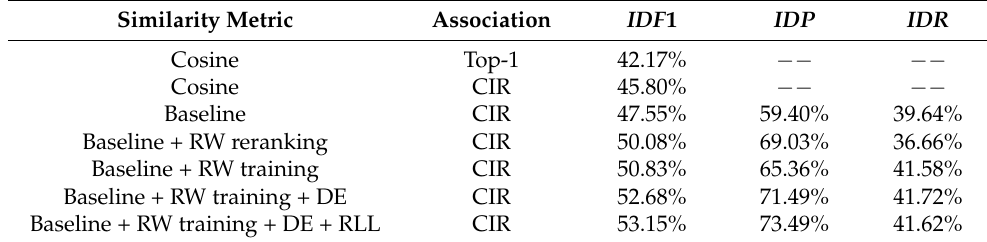
Table 4. Performance comparison of TSN modules. DE denotes the disentangle module.